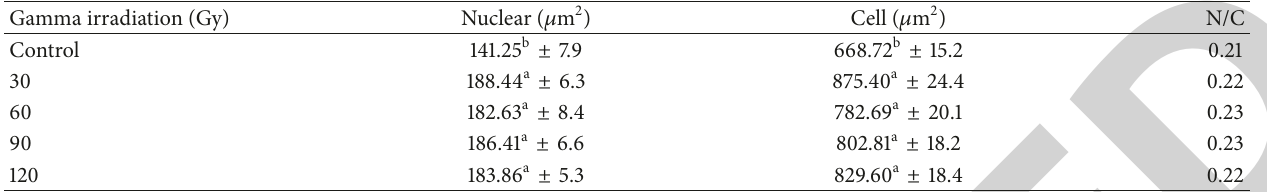
Table 5: Effect of gamma irradiation on cell and nuclear area of Onobrychis viciifolia in in vitro growth culture.